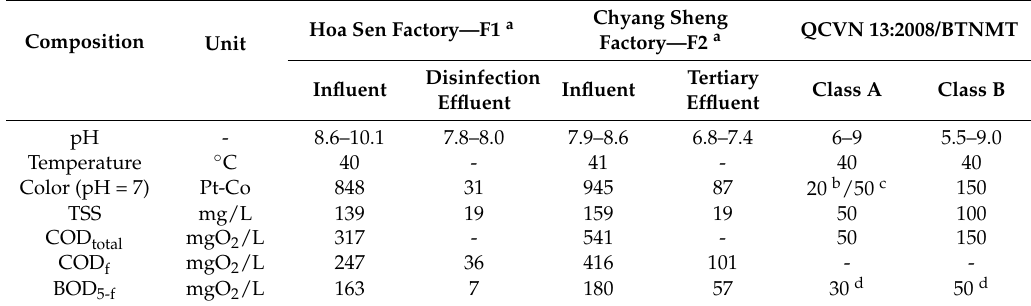
Table 3. Compositions of influent and effluent textile wastewater at the two